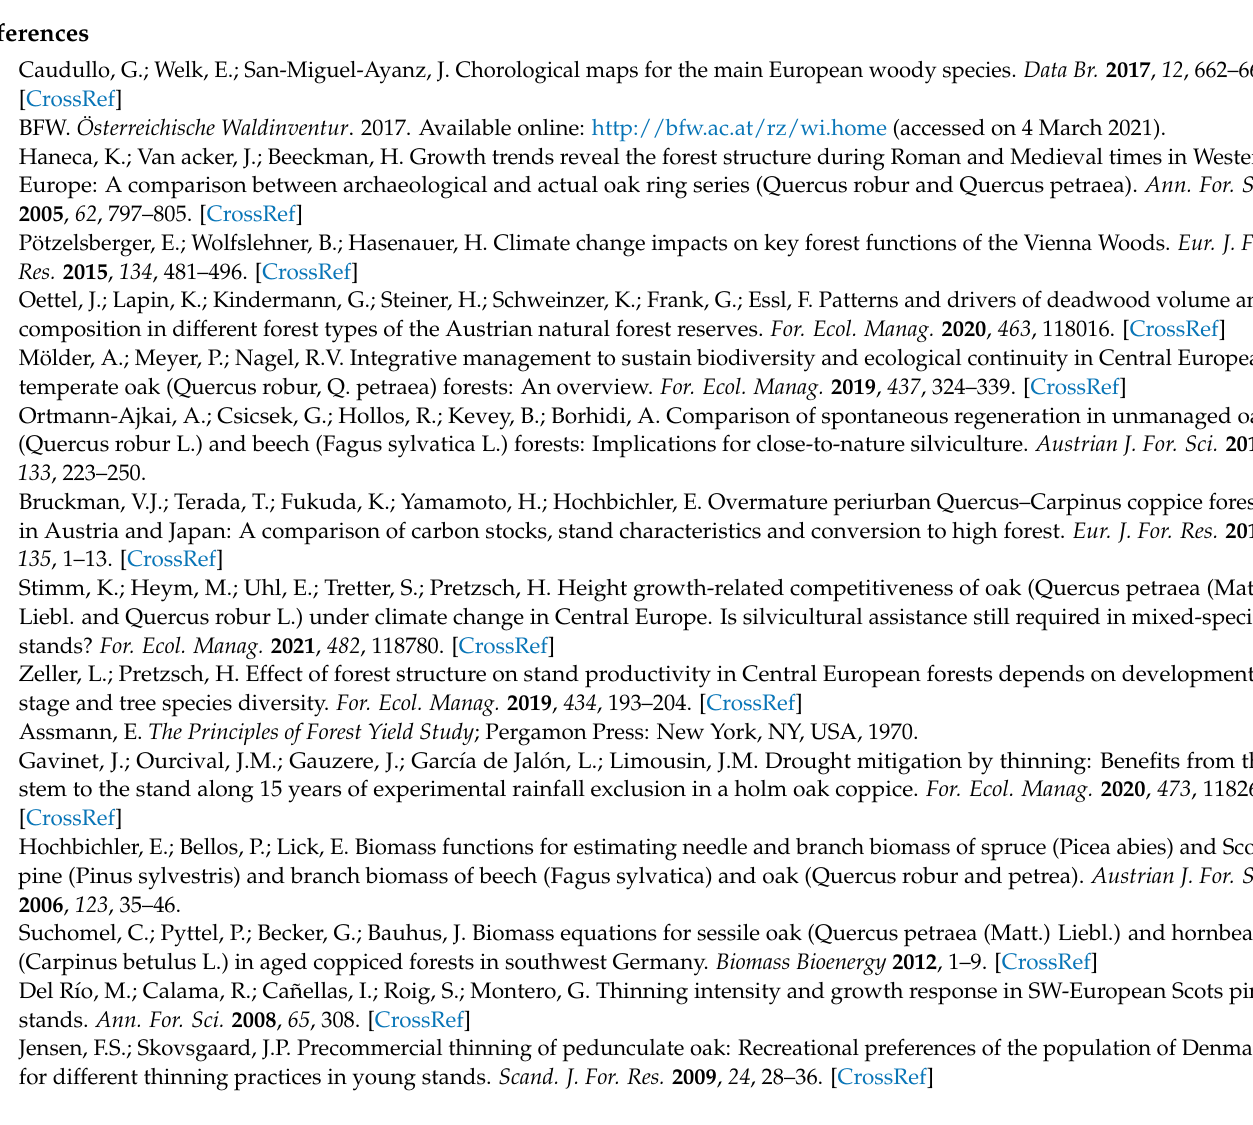
Figure A7. DBH increment by species ( a ) and by stand ( b ). The boxes represent the median and the 25th and 75th percentile, the whiskers extend to 1.5 of the interquartile range. Observations outside the interquartile range are shown as dots.